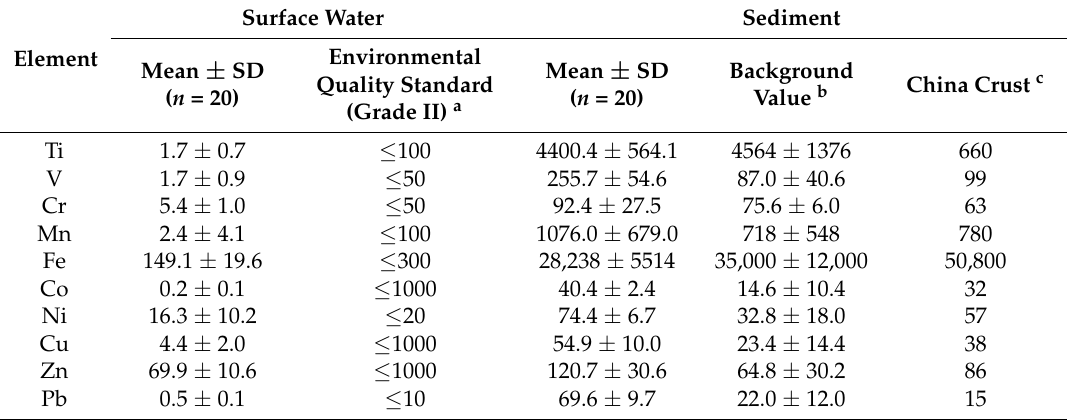
Table 1. Heavy metal concentrations in surface waters ( µ g L − 1 ) and sediments (mg kg − 1 , dry weighted (DW)) of Taihu